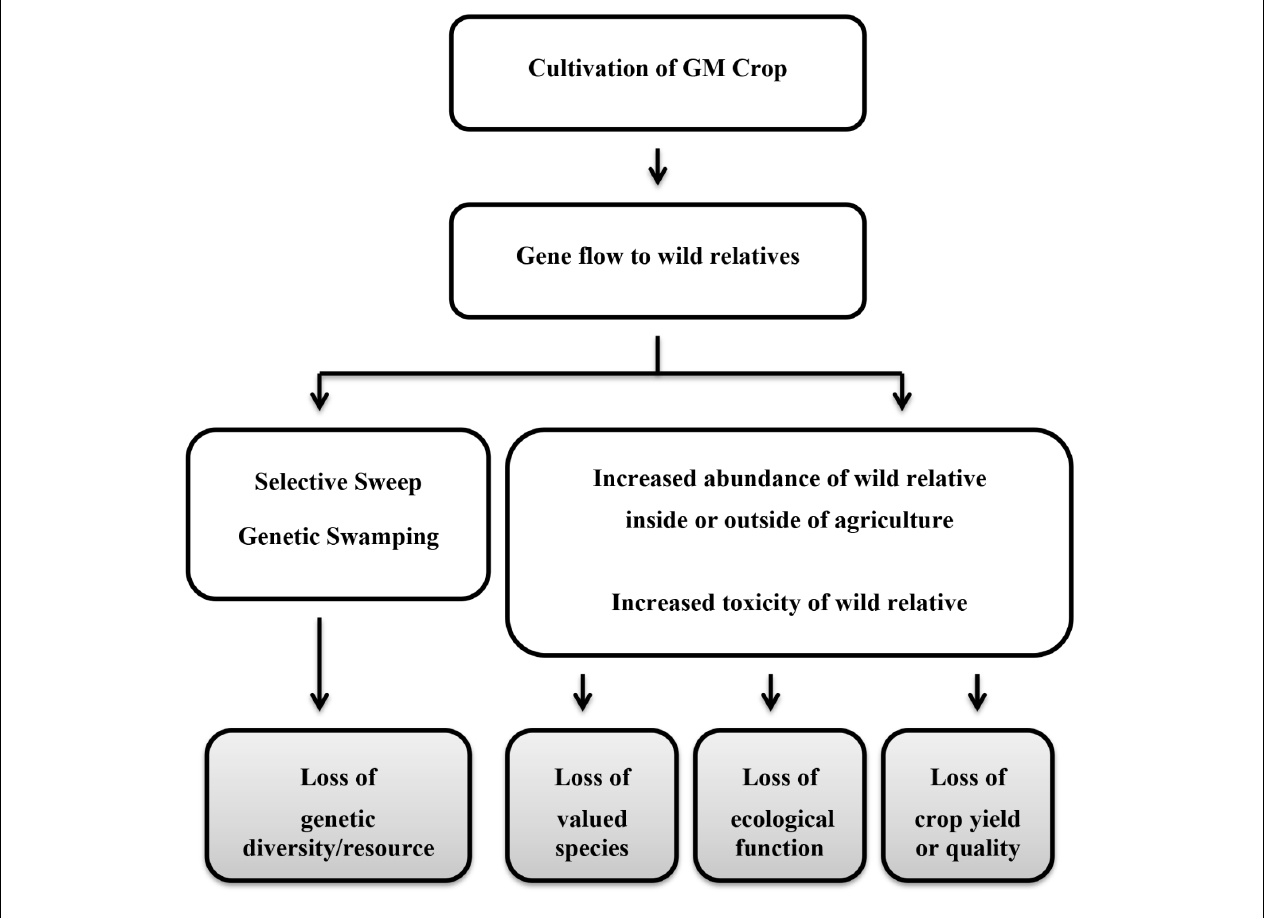
FIGURE 1 | Simplified pathways to harm resulting from gene flow to a wild relative. Gray boxes indicate the harm (adverse